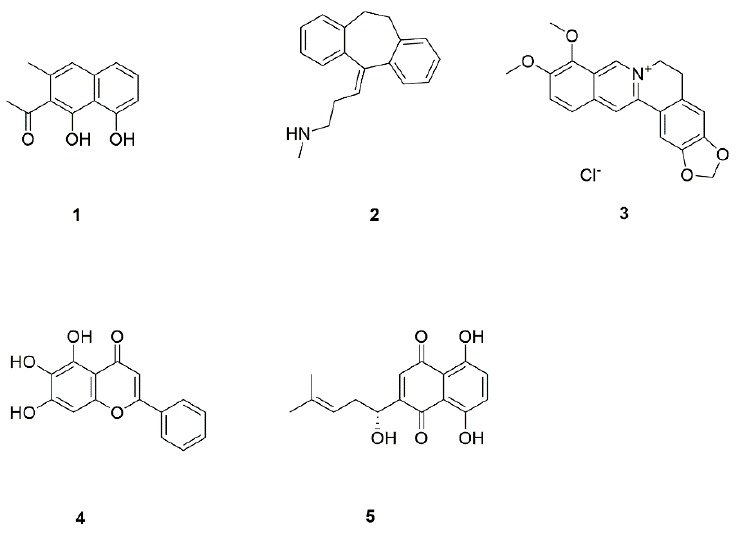
Figure 3. Chemical structures of natural compounds targeting various virulence factors.